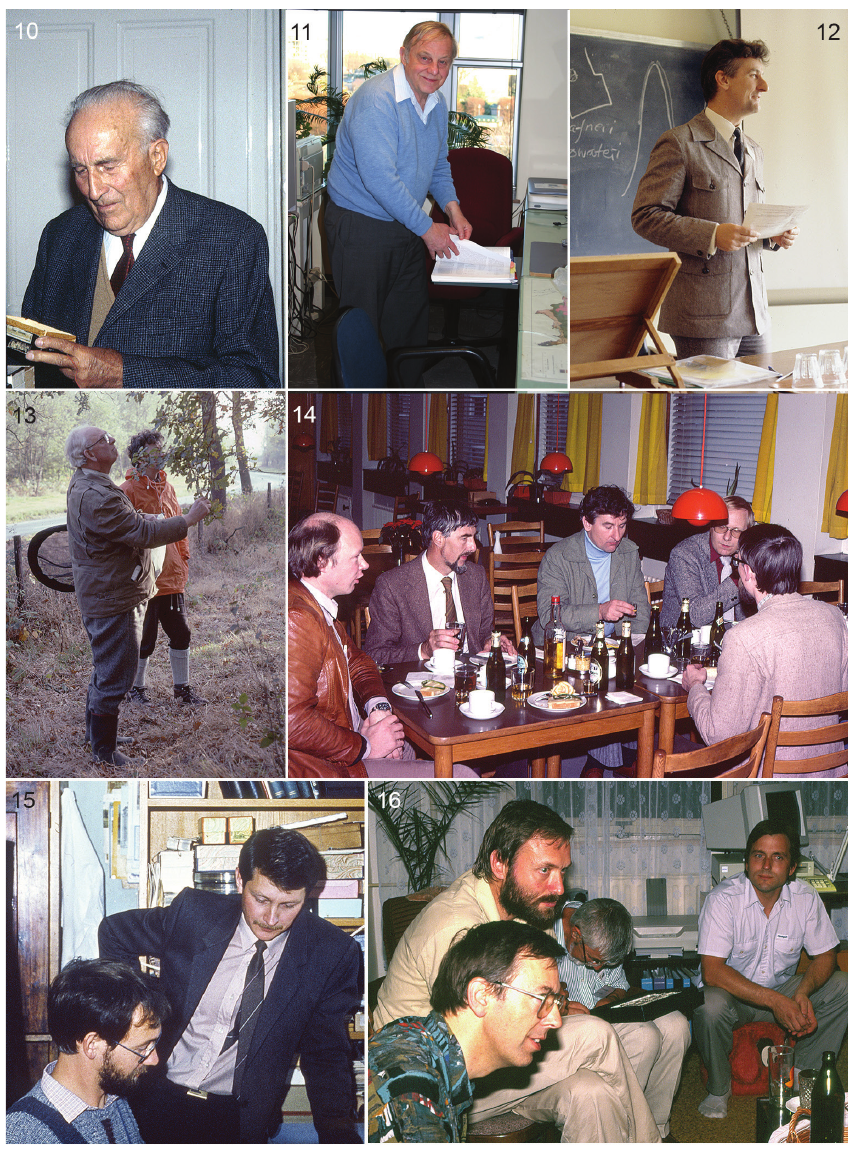
topher Wilkinson, April 1982, Cambridge, European Congress of Lepidopterology 13 Arthur Maitland Emmet, with C Wilkinson, Essex, UK, October 1979 14 Meeting for preparation of the Nepticulidae volumes for Fauna Entomologica Scandinavica, Copenhagen, October 1980: from left: Ebbe S. Nielsen, Roland Johansson, Chris Wilkinson, Bert Gustafsson, Niels Peder Kristensen 15 Rimantas Puplesis, standing (now Jonas R. Stonis), Erik J. van Nieukerken, in Zoological Institute, Leningrad, September 1985 16 Get together of leafminer enthusiasts at house of Aleš Laštůvka, Prostejov, Czech Rep., Septem- ber 1994, from left: Steven Whitebread, Zdeněk Laštůvka, Roland Johansson, Aleš Laštůvka. Scans from transparencies by Erik J. van